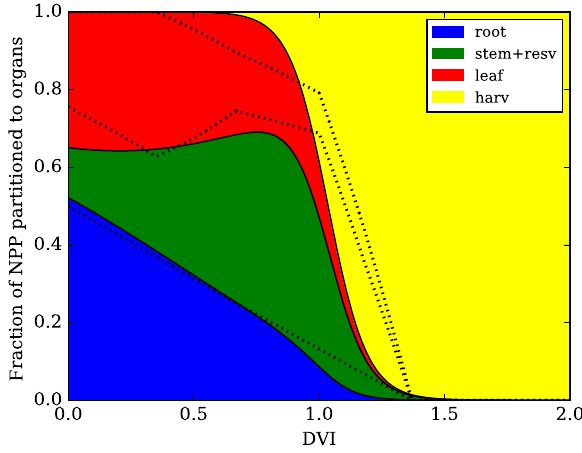
Figure 2. Partition fractions as a function of DVI using the tuned parameters. The dotted lines are from de Vries et al.